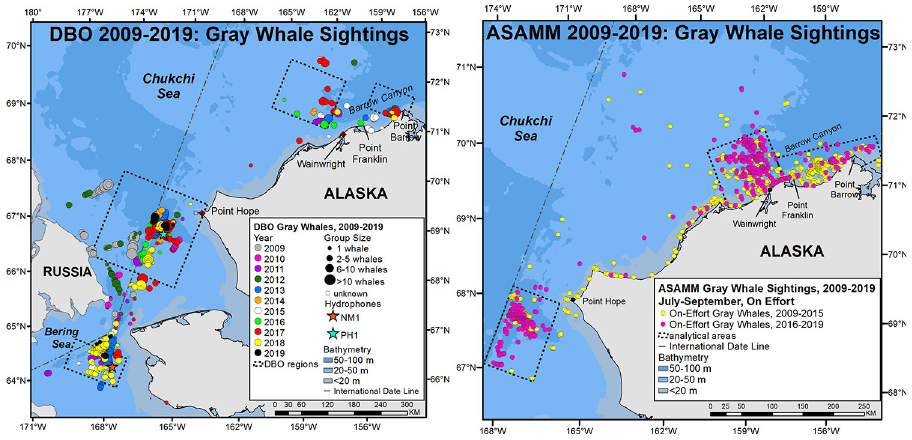
Fig 4. Gray whale distribution from sightings made during marine mammal watches on DBO cruises, and the broad scale Aerial Surveys of Arctic Marine Mammals (ASAMM) program, 2009–2019. Dashed lines depict boundaries of DBO regions and analytical areas, respectively. Gray whale sighting rates (SR = whales/km) in analytical areas were calculated solely from ASAMM data. ASAMM data are publicly available at fisheries.noaa.gov/resource/ data/1979-2019-aerial-surveys-arctic-marine-mammals-historical-database. Databases used for maps include versions 1979_2011_v3_36, 2012_2014_v0_28, 2015_2017_v22, and 2018_2019_v6.